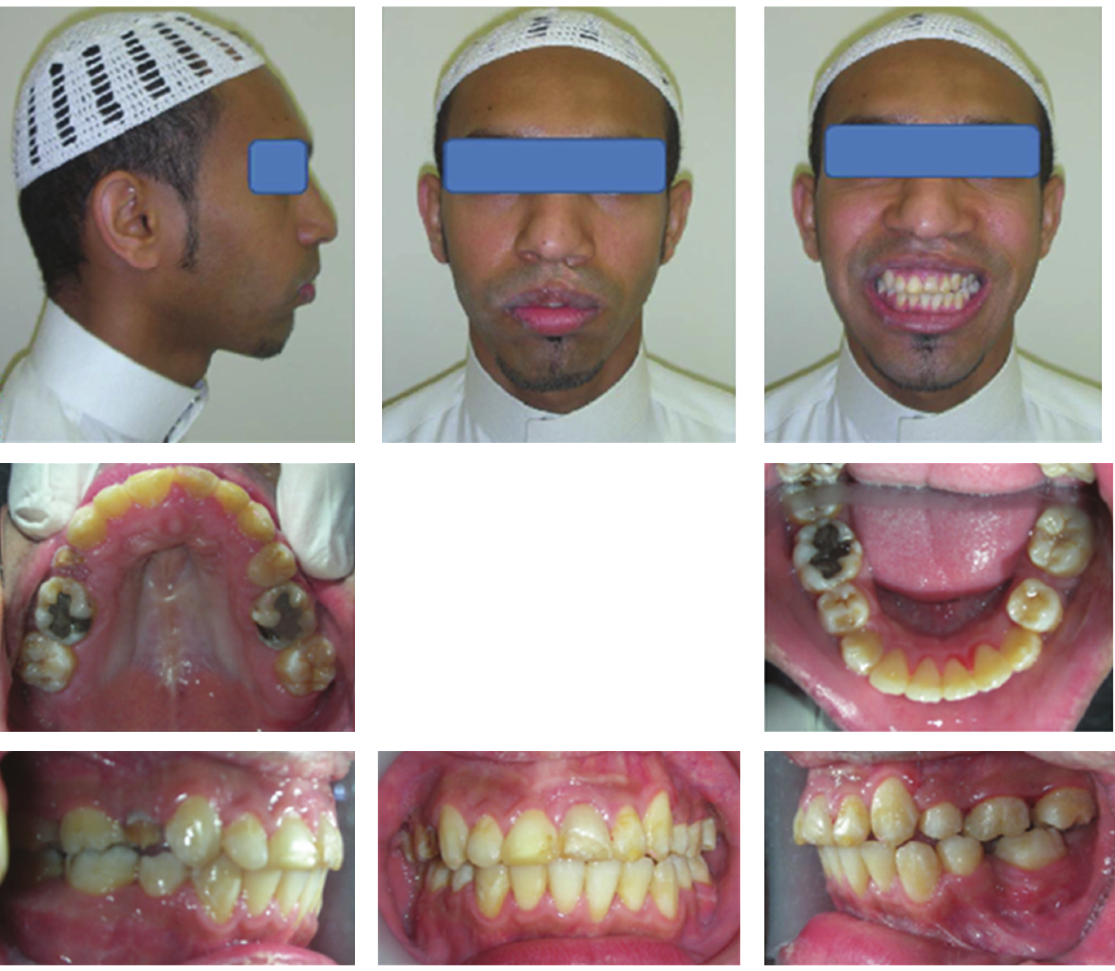
Figure 4: Posttreatment extraoral and intraoral